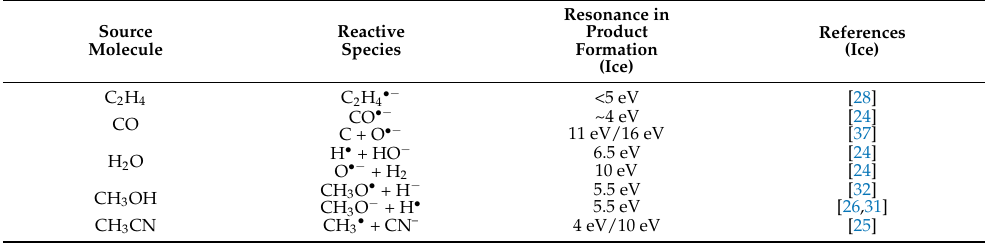
Table 4. Reactive species formed by (D)EA as relevant to the electron-induced reactions in molecular ices discussed in Section 4. Note that the listed species were not directly detected but their contribution to the reactions is deduced indirectly from the identified final reaction products. Other electron- molecule interactions may contribute as well as summarized in Sections 3.2 and